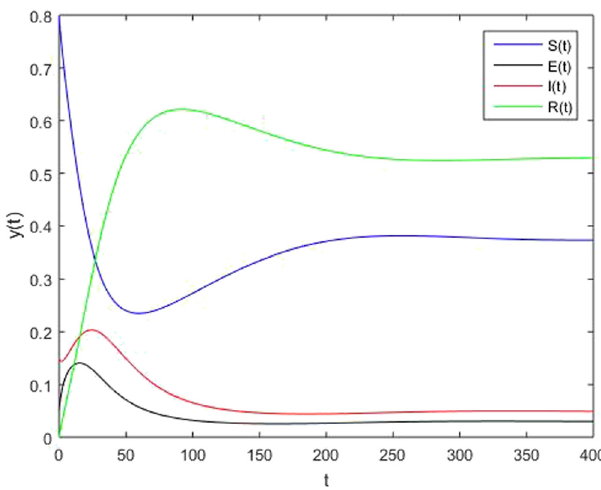
Figure 3: A solution to the SEIR model with fractional order α =